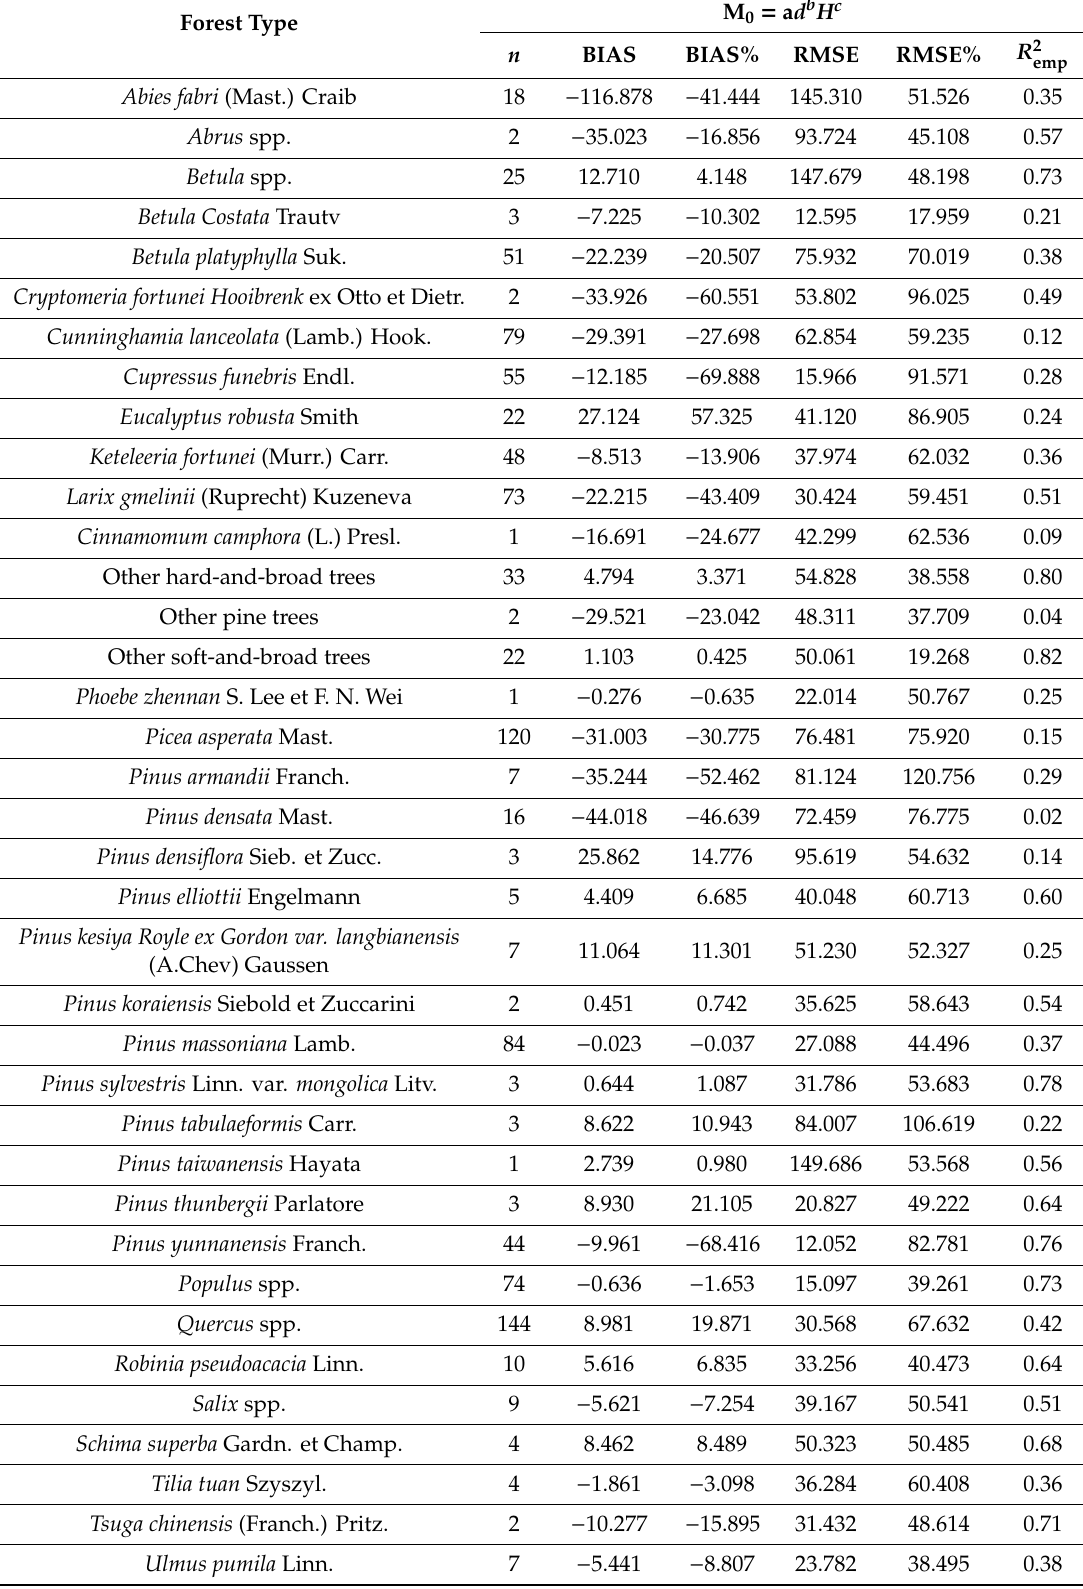
Table A4. Validation of the stand volume precision binary volume model of di ff erent forest types. Forest Type